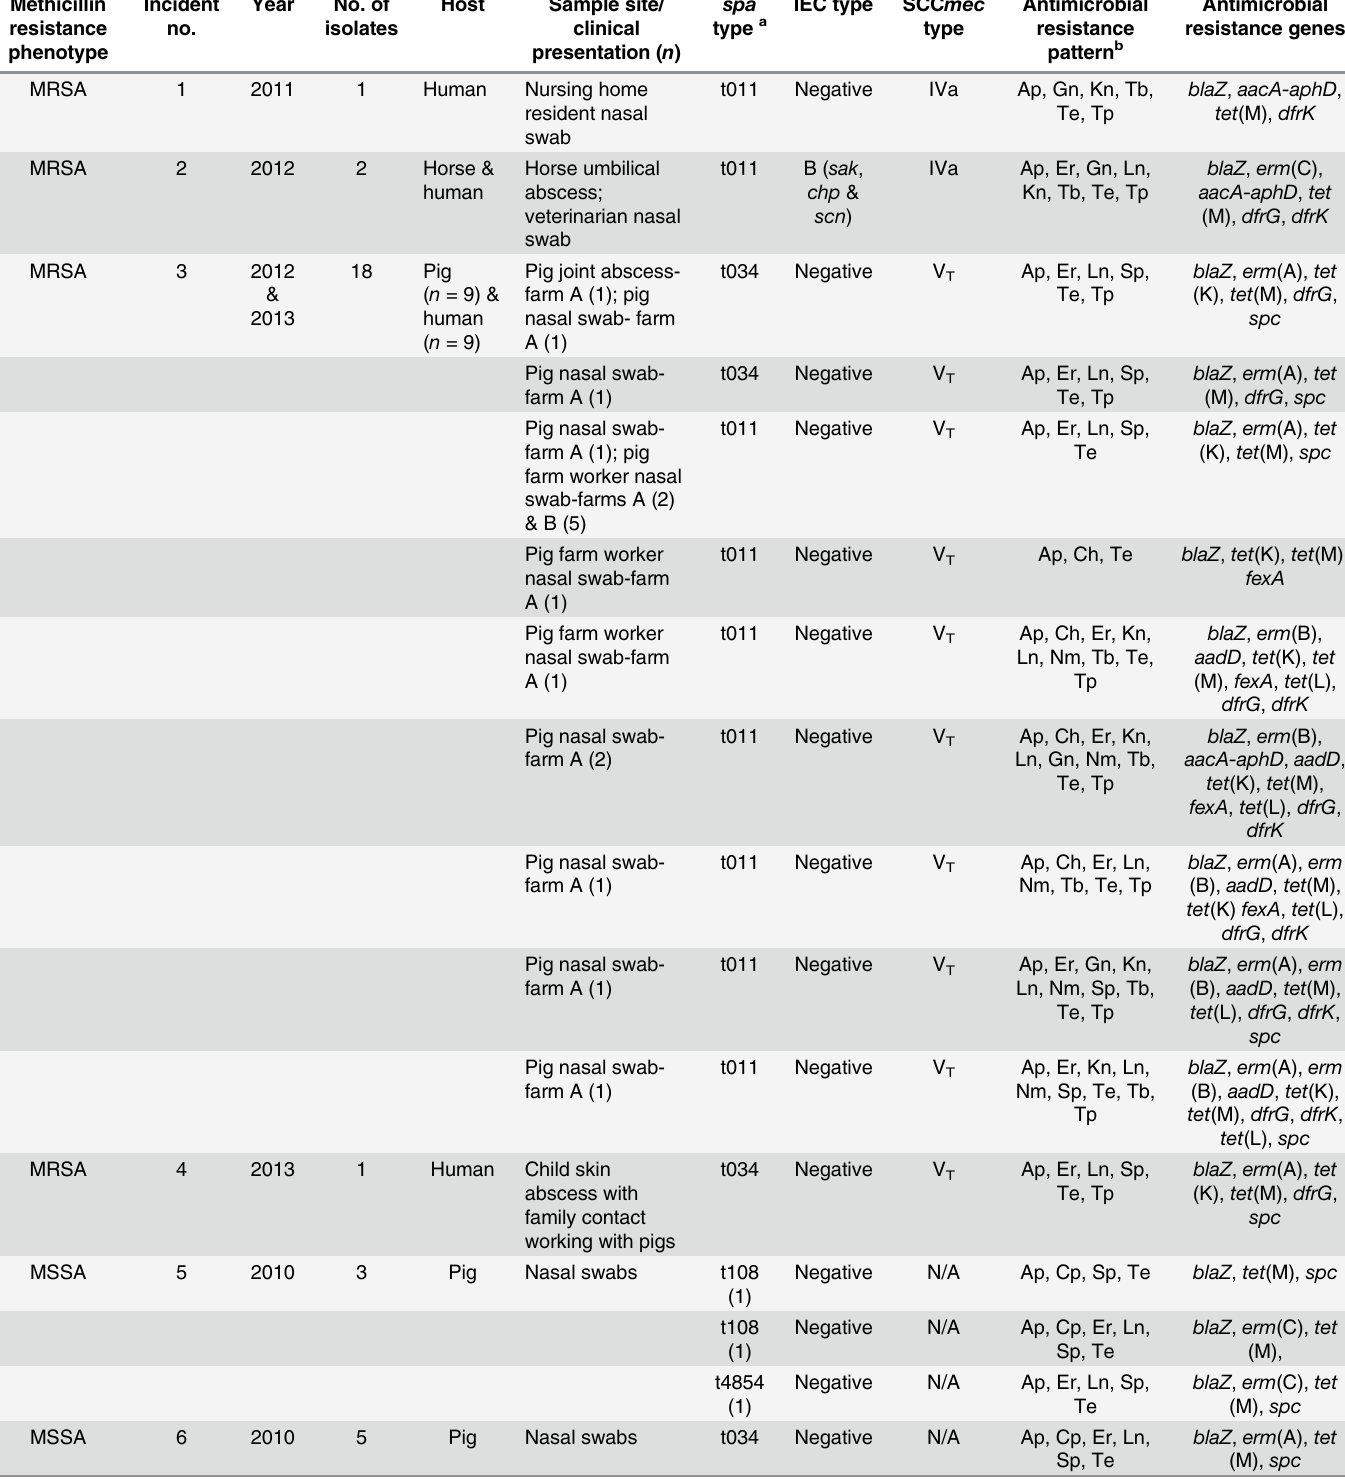
Table 1. Epidemiological, phenotypic and genotypic characteristics of CC398 methicillin-resistant and methicillin-susceptible S . aureus (MRSA and MSSA) identified in the Republic of Ireland among animals and humans. Methicillin